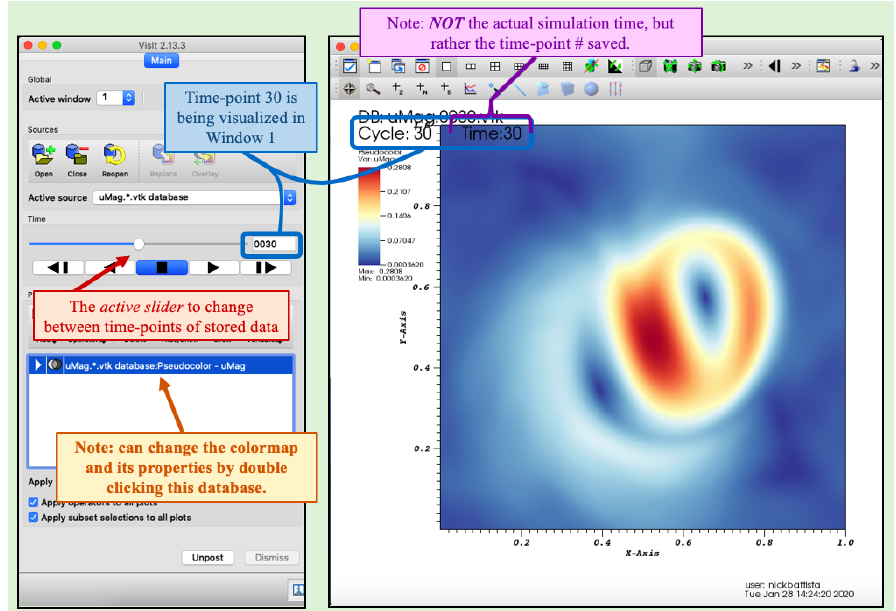
Figure 12. Changing the time-point to the 30th time-point stored.